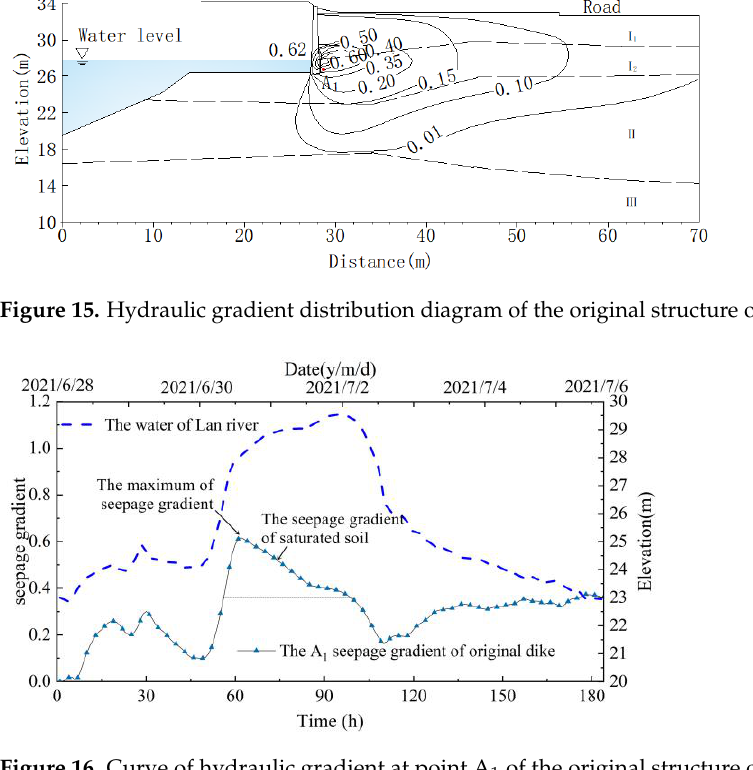
Figure 16. Curve of hydraulic gradient at point A 1 of the original structure of the ancient riverbank changing with the water level of Lanjiang River.